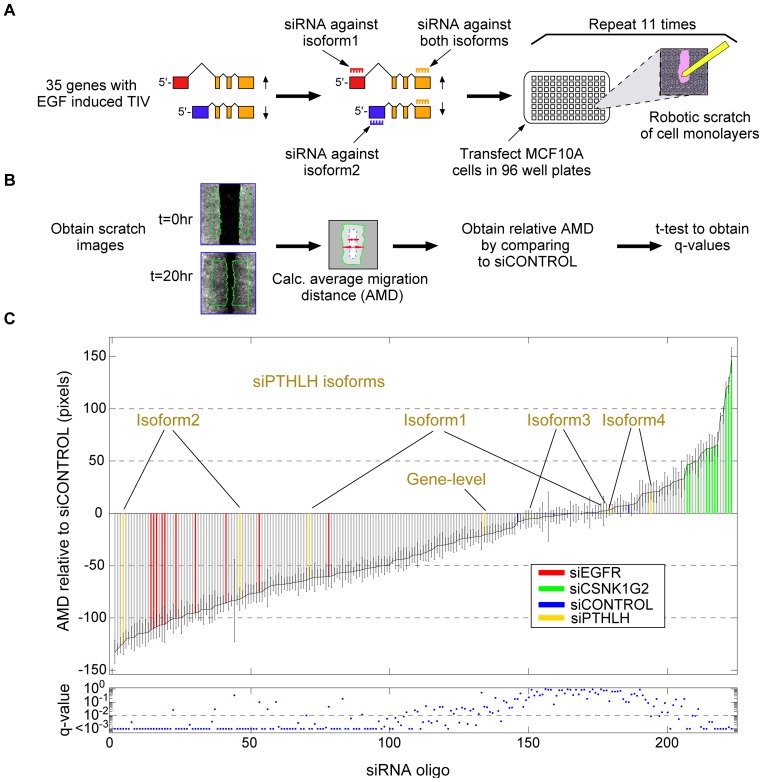
Functional tests of EGF-induced TIV by an isoform-specific siRNA screen.(A) For 35 genes, each transcript isoform undergoing EGF-induced TIV was targeted by two individual oligonucleotides and by ‘gene-level’ siRNA oligonucleotide pools knocking down all isoforms. An automated robotic platform was used for performing scratches. Each candidate was screened in eleven biological replicates. (B) Scheme of the automated image analysis used to calculate the average migration distance (AMD) for each well compared to control siRNA oligonucleotides (C) Upper panel: Each bar represents the measured mean relative AMD (and standard error) for one oligonucleotide. Lower panel: The FDR q-values, relative to the control siRNA, are shown.